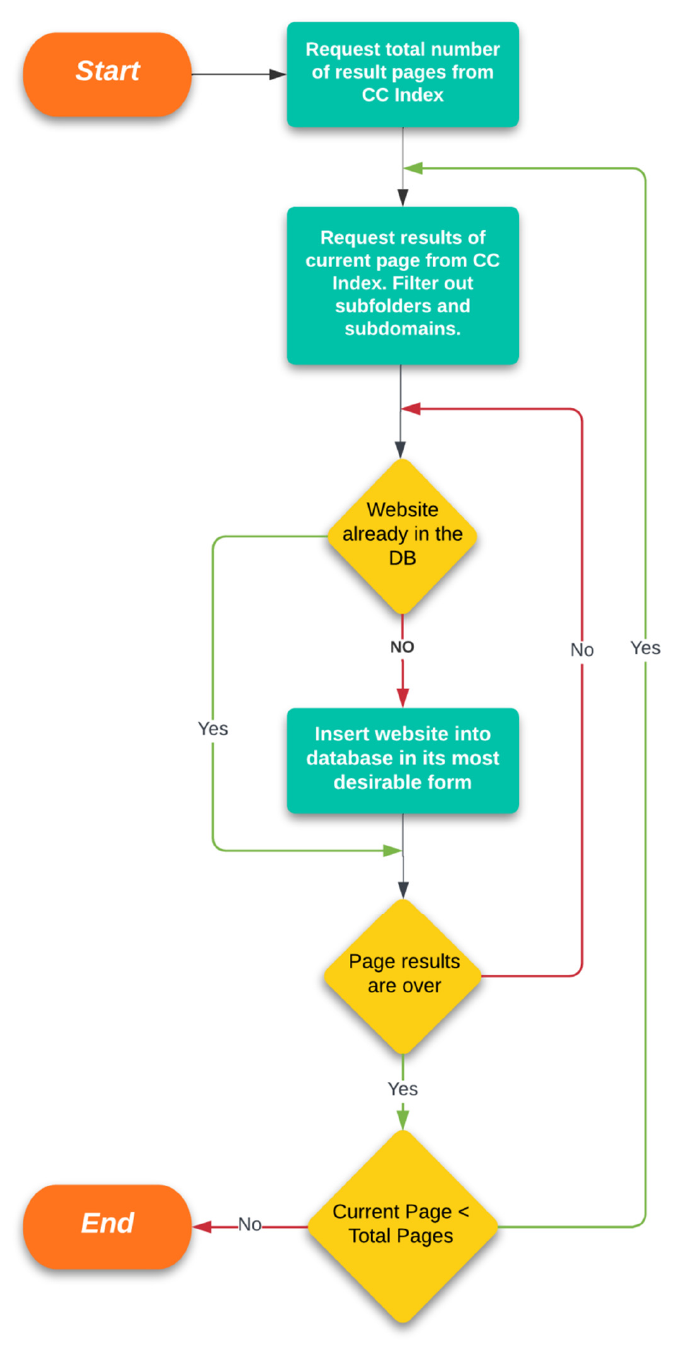
Figure 3. Flowchart of the .eu domains discovery algorithm.